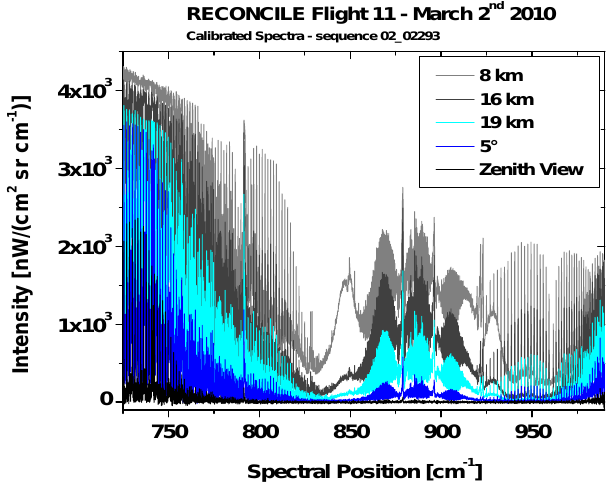
Fig. 5. Examples for single calibrated spectra from RECONICLE flight 11 on 2 March 2010. In the box in the upper right side, the corresponding tangent altitudes/elevation angles of the spectra are listed (0 ◦ elevation corresponds to horizontal view).